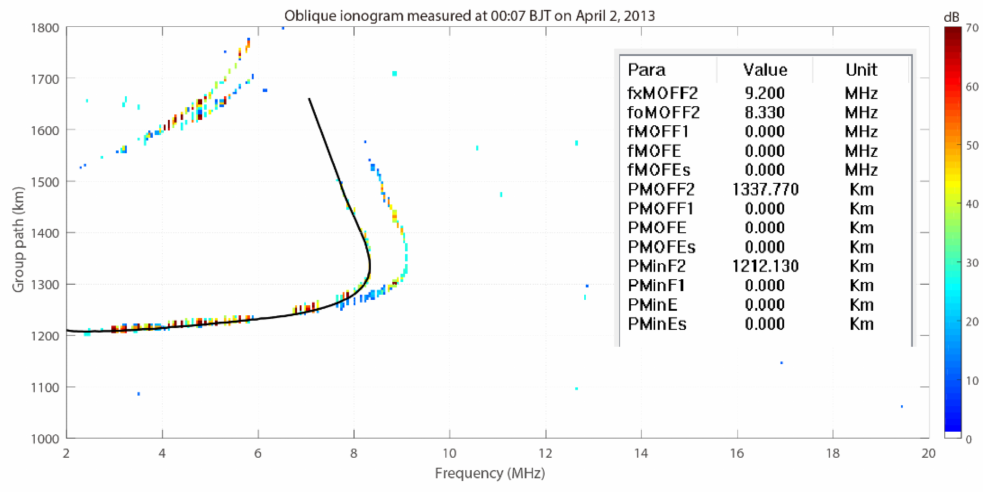
Figure 7. Similar to Figure 6, but the oblique ionogram was measured at 00:07 BJT on 2 April 2013 without the F1